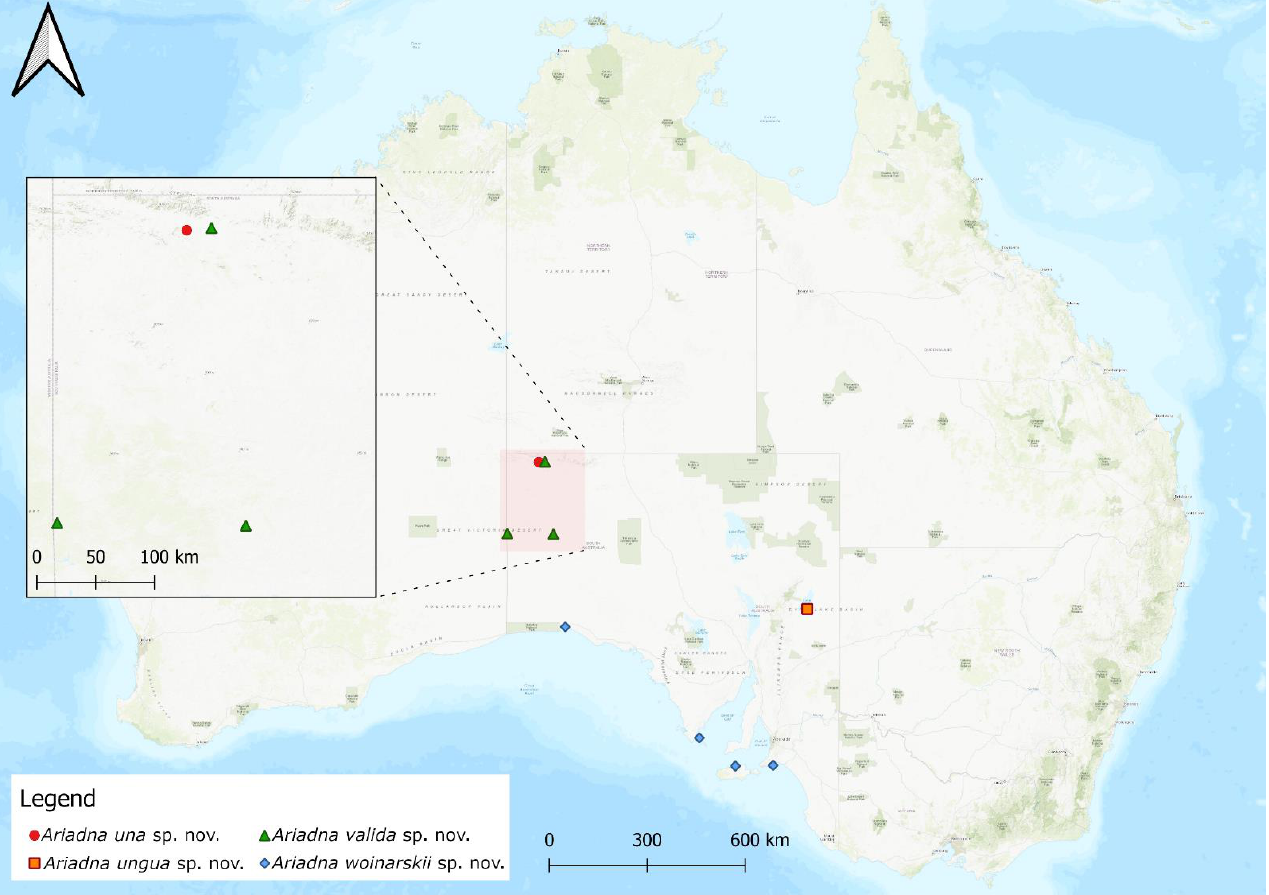
Figure 64. Map showing the currently known distribution of A. una sp. nov. , A. ungua sp. nov. , A. valida sp. nov. and A. woinarskii sp. nov. Ariadna ungua sp. nov. Figure 64, Figure 65a–h, Figure 66a–c, Figures 67a–h and